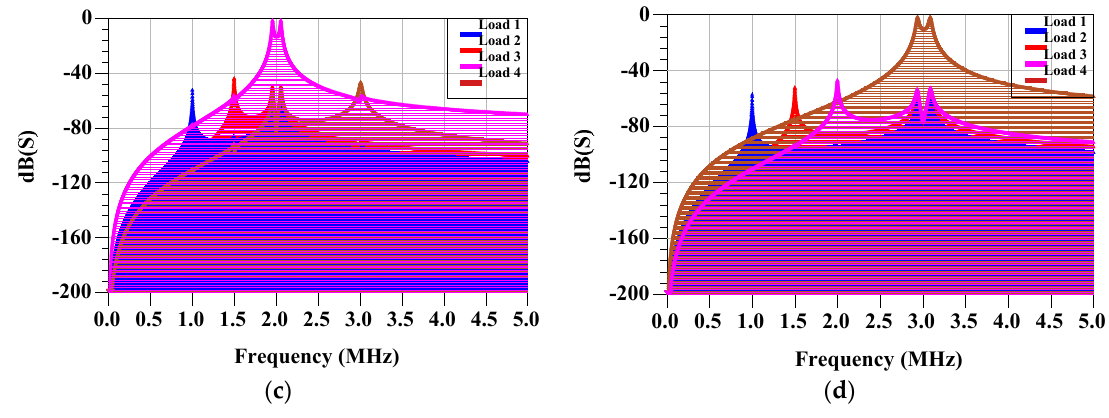
Figure 7. dB of the coil with cross-coupling compensation ( a ) dB(S) when Rx1-on; ( b ) dB(S) when Rx2-on ( c ) dB(S) when Rx3-on; ( d ) dB(S) when Rx4-o n.